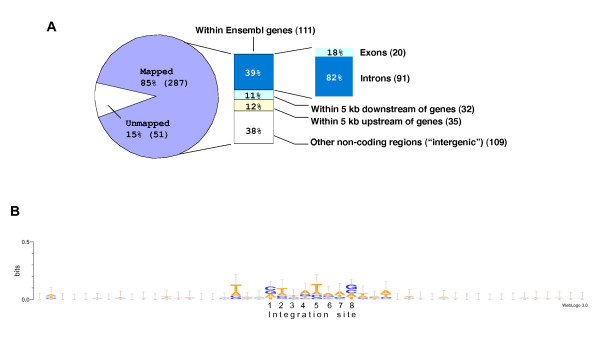
Tol2 integration properties. A: Distribution of Tol2 insertions in respect of endogenous genes. B: Tol2 integration site motif analysis. A graphical representation of a nucleic acid multiple sequence alignment (n = 368) was generated by WebLog (version 3.0).